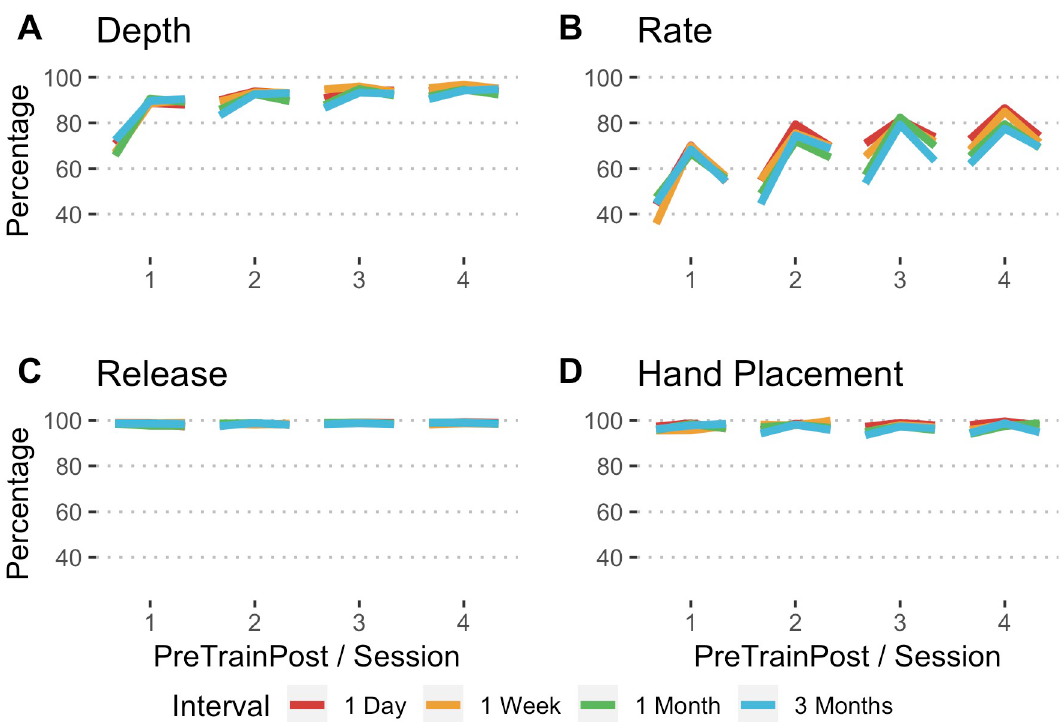
Fig 3. Mean percentages of compressions with adequate depth, rate, release, and hand placement by interval, session, and pretest/training/posttest assessment.